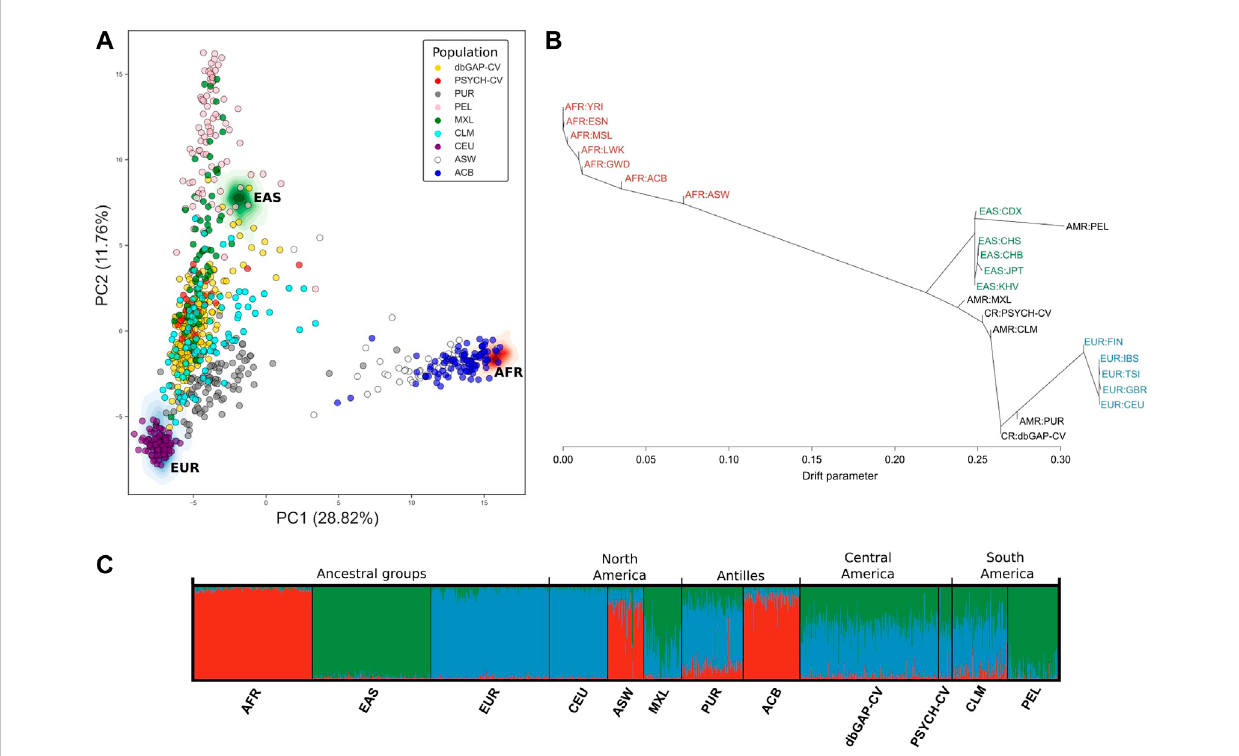
FIGURE 3 Genetic similarity between Latin American individuals based on genotypes of 446 AIMs reported by Galanter et al. (2012). (A) Principal component analysis. (B) Genetic relationships between the populations included in the analysis according to TreeMix estimates. (C) Individual genetic structure plot. Featured 1KGP populations - EUR: Eastern Europe, AFR: Africa, EAS: Eastern Asia, ACB: Barbados, ASW: African Ancestry in Southwest US, CEU: Utah, CLM: Colombia, MXL: Mexico, PEL: Peru, PUR: Puerto Rico, PSYCH-CV: Psychiatric study Central Valley, dbGAP-CV: dbGAP Central